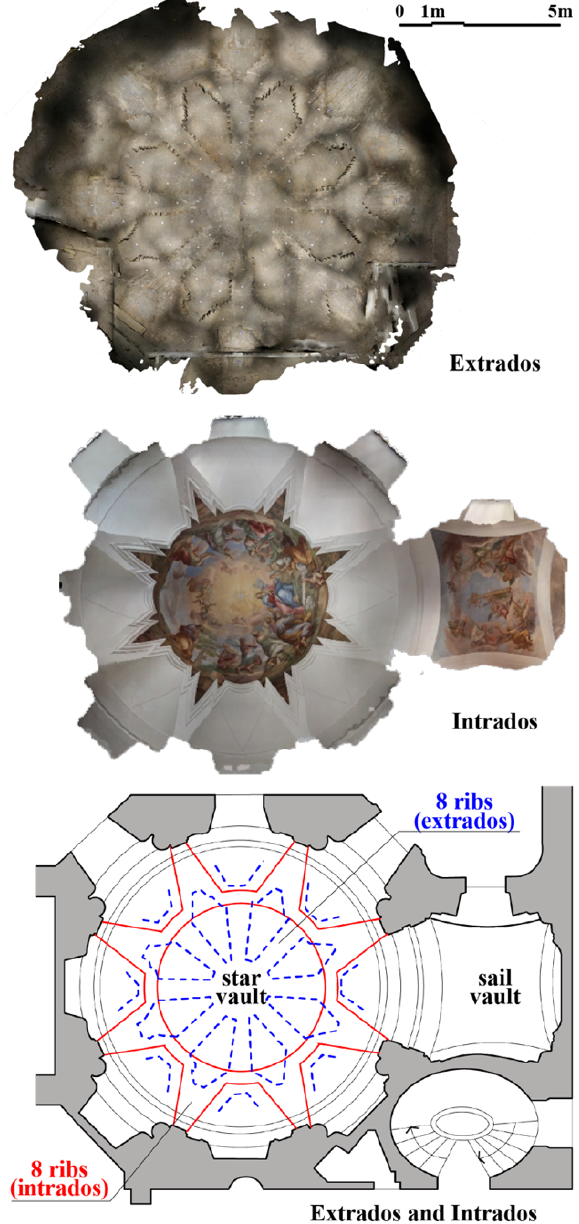
Figure 3. Top: orthomosaic of the chapel extrados. To be noticed the ‘inverted Y’ ribs and their rhomboidal configuration. Middle: orthomosaic of the chapel intrados. To be noticed the star design. Bottom: The drawing of the overlapping intrados (red) and extrados (blu) of St.